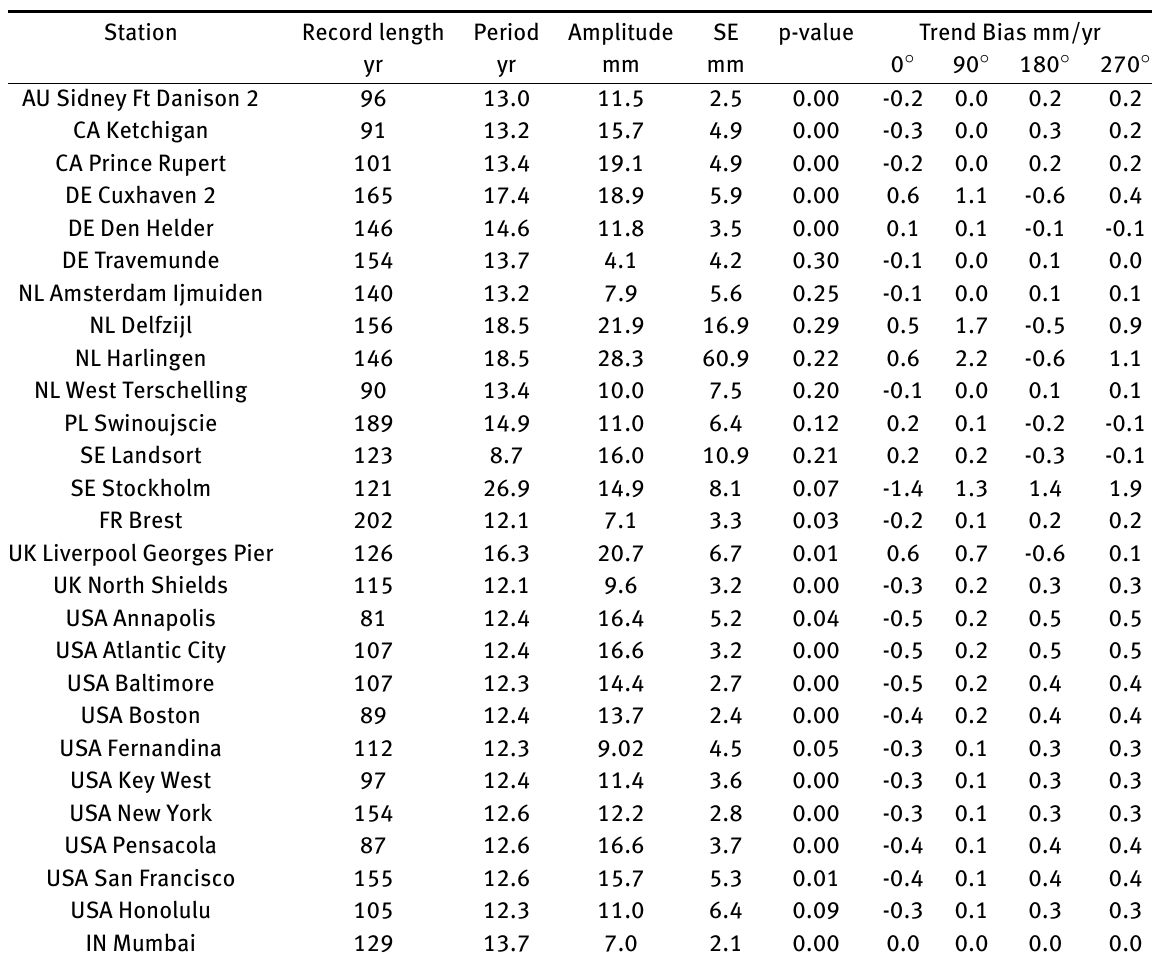
Table 1: The estimated amplitudes and their standard errors (SE) for the periods detected by the spectral analyses are shown. Shaded p - values refer to the statistically significant amplitude at α = 0.05 level. Predicted trend/velocity biases (mm/yr.) in short series such as satellite altimetry are assumed to be 20 year-long. Biases were computed for 0 ∘ , 90 ∘ , 180 ∘ and 270 ∘ phase angles using amplitudes of unmodeled periods detected in this study. Trend biases in shaded cells refer to the statistically significant harmonics at p <0.05.